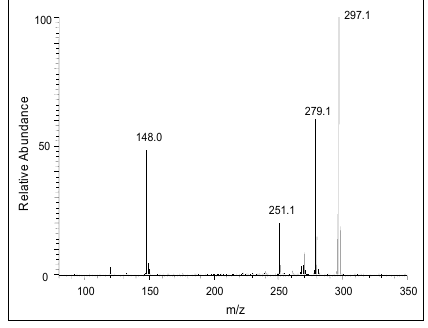
Figure 6. The CID mass spectrum of the ion with an m / z value of 297 amu.